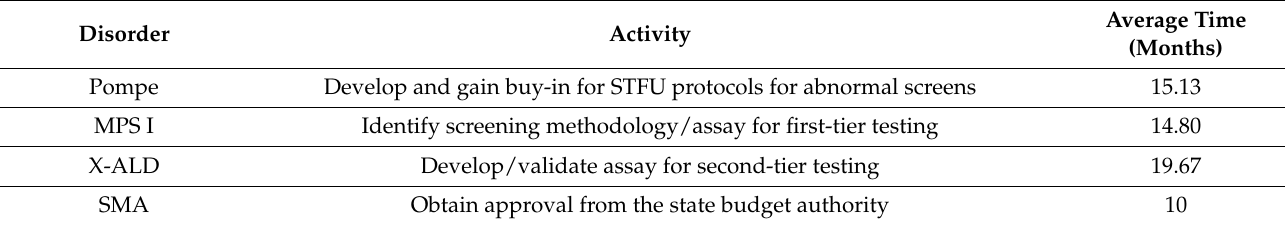
Table 4. The most time-intensive activity by disorder. Preliminary results from NewSTEPs New Disorder Readiness Scale, as of 31 August